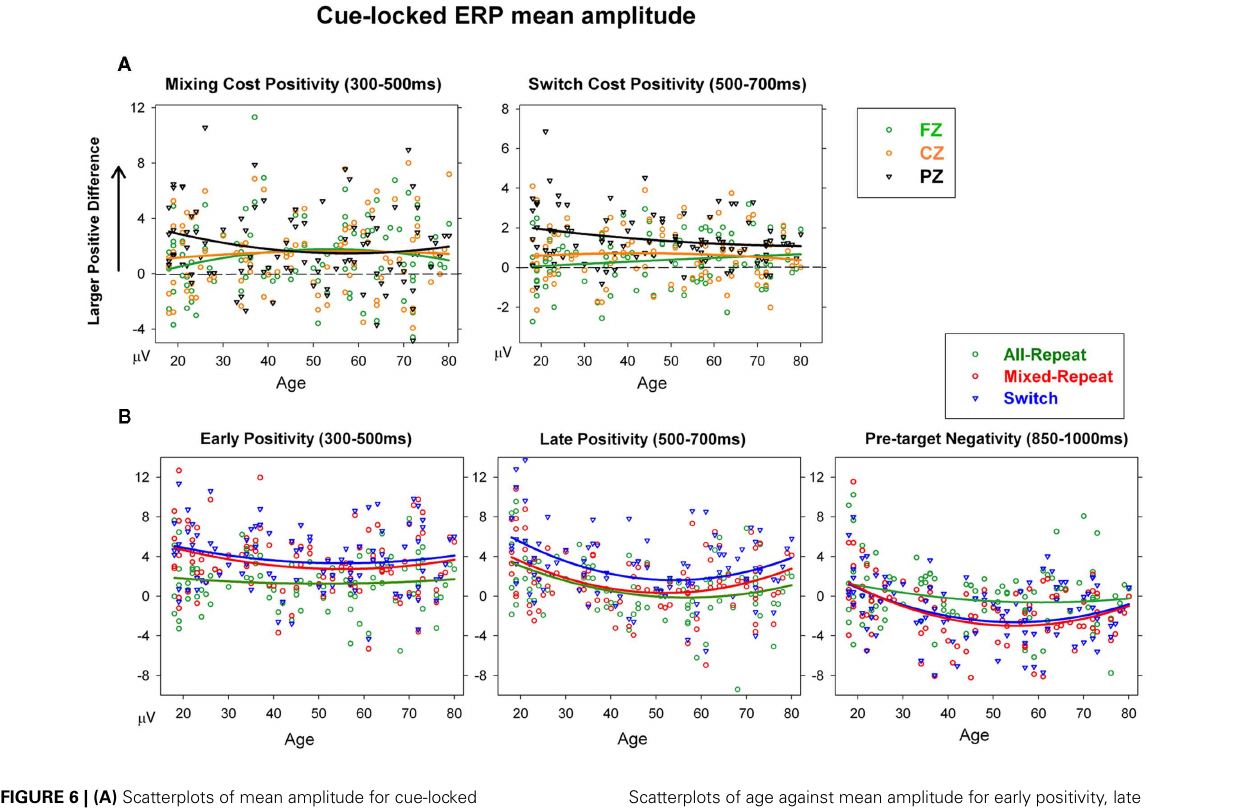
FIGURE 6 | (A) Scatterplots of mean amplitude for cue-locked mixing cost positivity (mixed-repeat – all-repeat) and switch cost positivity (switch – mixed-repeat) at each midline electrode. (B)